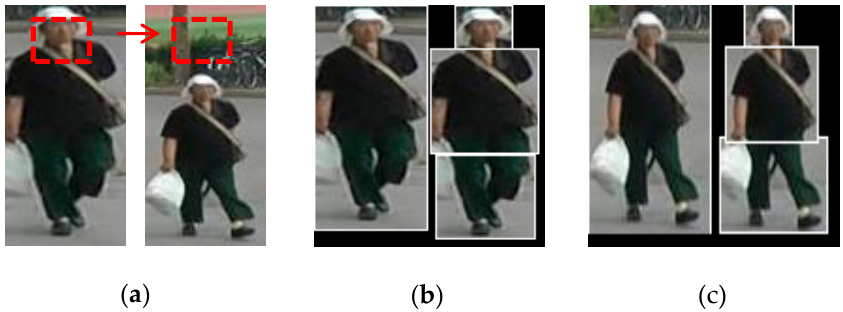
Figure 4. Example of body part alignment based on part segmentation. ( a ) An example of part misalignment; ( b ) Aligned image and part patches of left image in ( a ); ( c ) Aligned image and part patches of right image in ( a ).